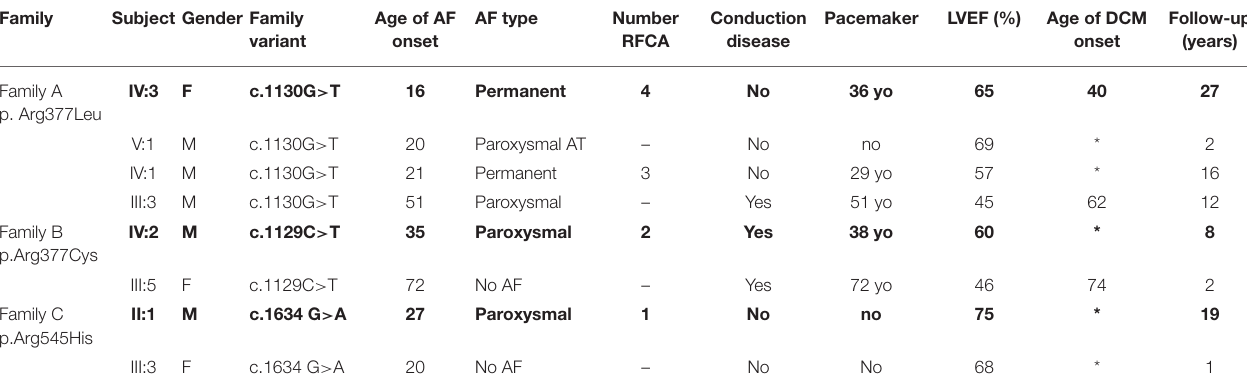
TABLE 2 | Summary of clinical findings in 8 lamin A/C genotype-positive